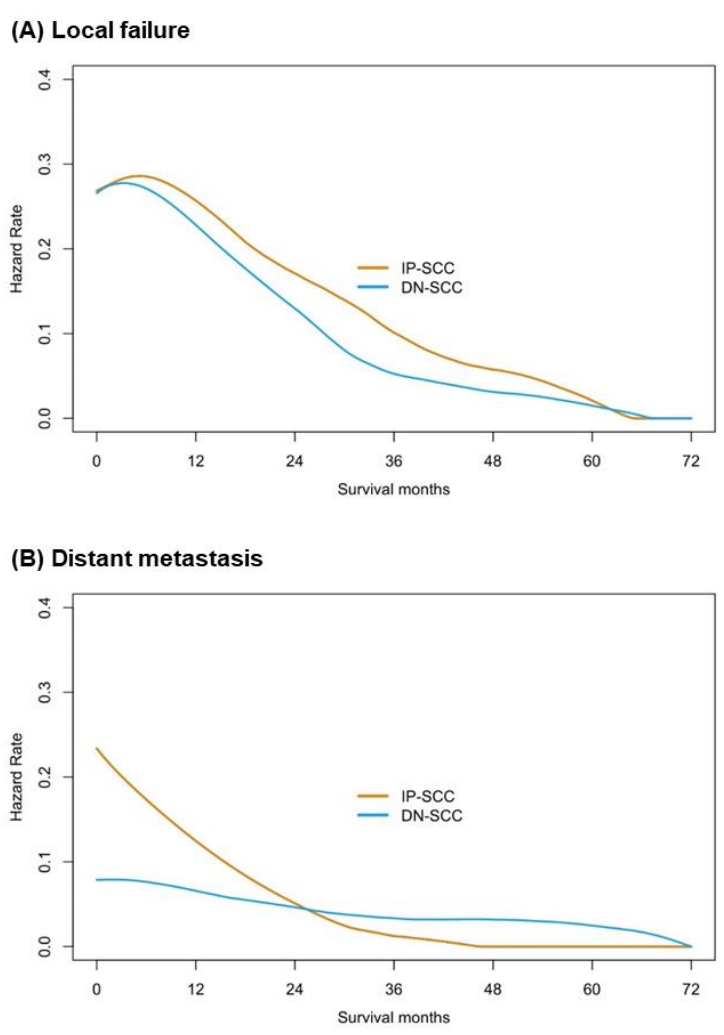
Figure 4. The annual hazards of local failure and distant metastases for patients with IP-SCC and with